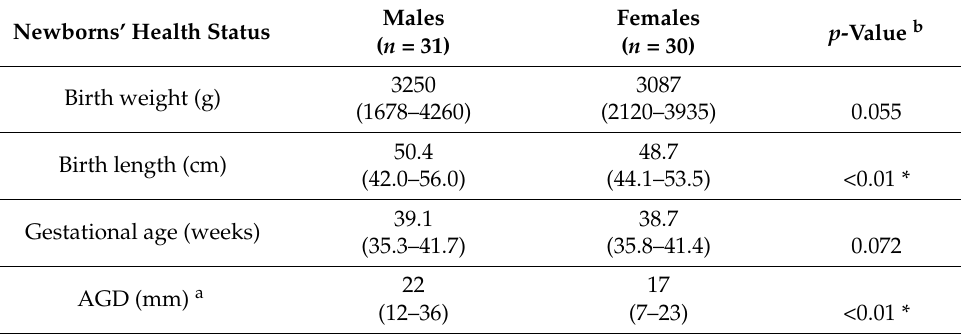
Table 1. Physical examination of health status in newborns ( n = 61) a .